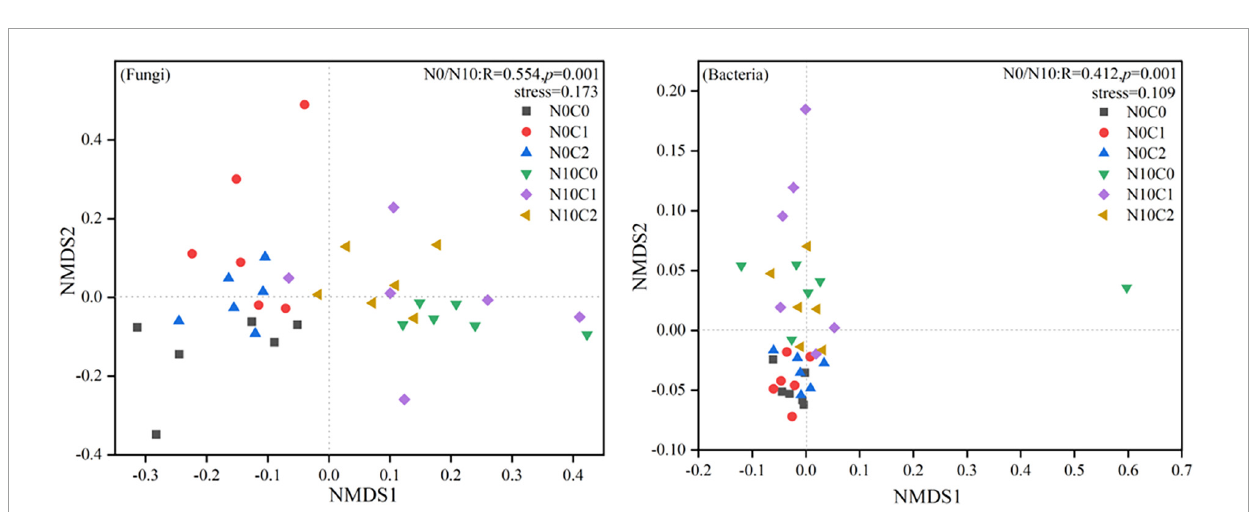
FIGURE3 Non-metric multidimensional scaling (NMDS) analysis of soil fungal and bacterial beta diversity in N addition and litter manipulation treatments during 2014–2019. R and p -values under the non-nitrogen (N0) and nitrogen addition (N10) treatments comes from the ANOSIM